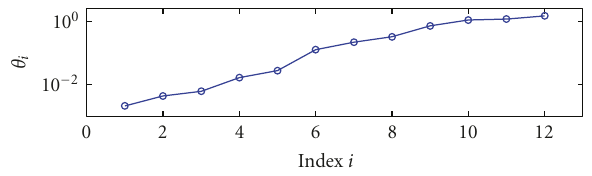
Figure 12: The canonical angles θ 1 , ... , θ k (radians) associated with the matrices V k and V L , k from the SVD and the ULV decomposi- tions computed by the high-rank hulv